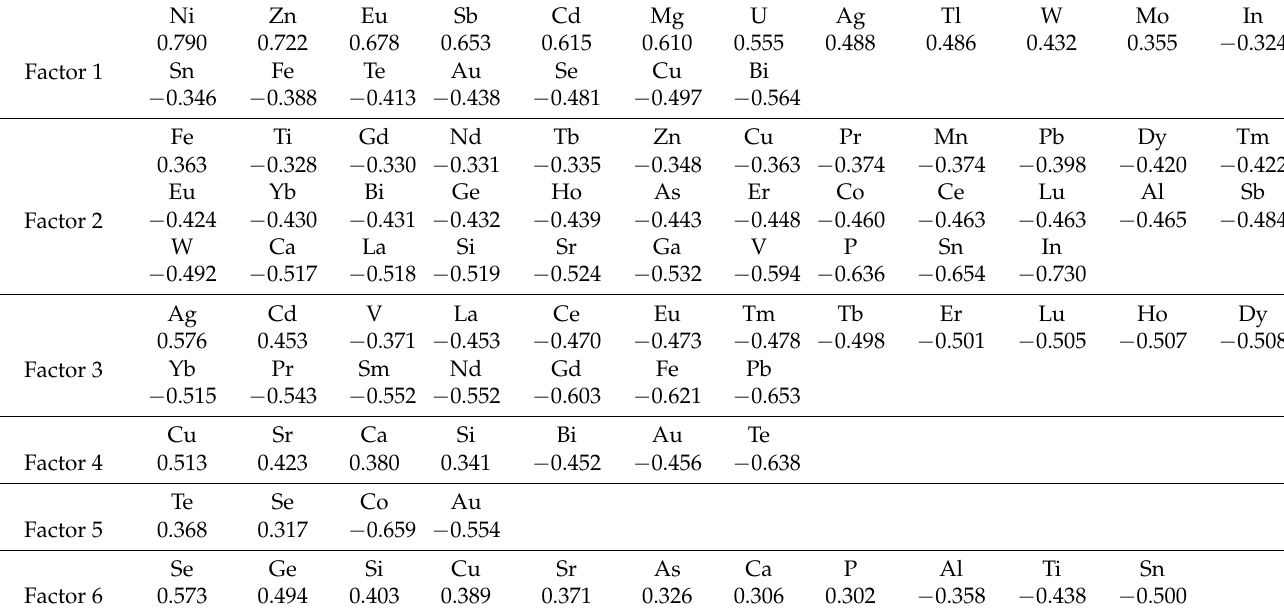
Table 5. Q-mode factor scores for the IOH types of the Pobeda-1 hydrothermal